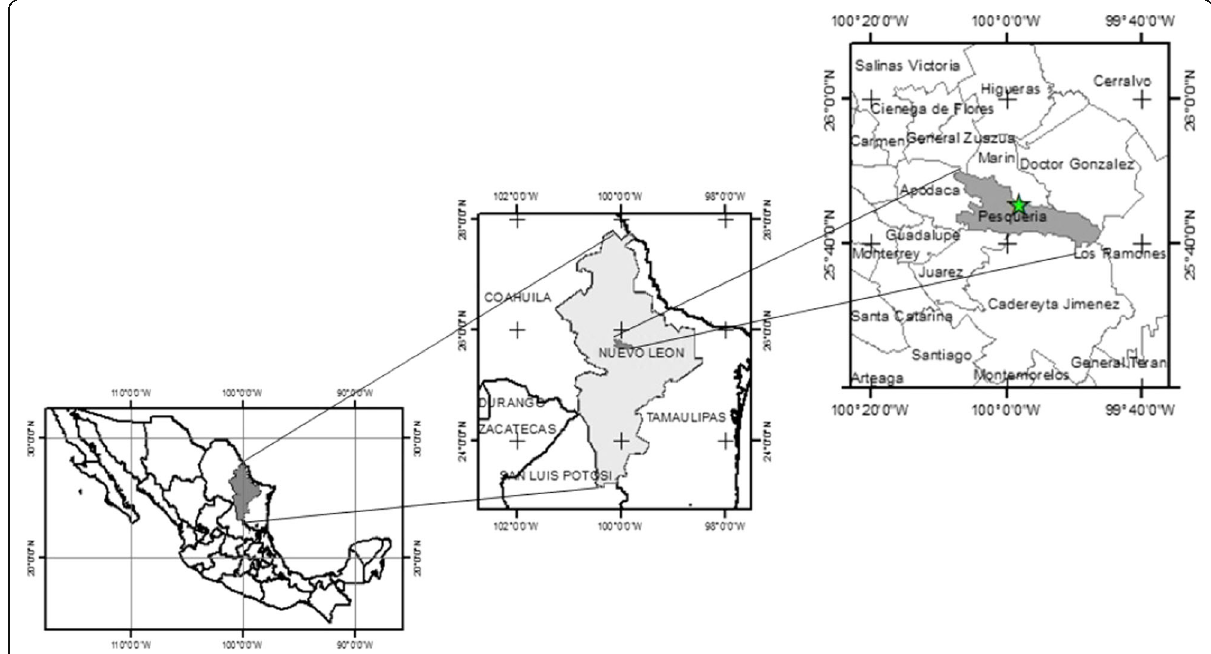
Fig. 1 General location of study area. From left to right: Mexico, Nuevo León and the municipality of Pesquería. The study area is indicated with a